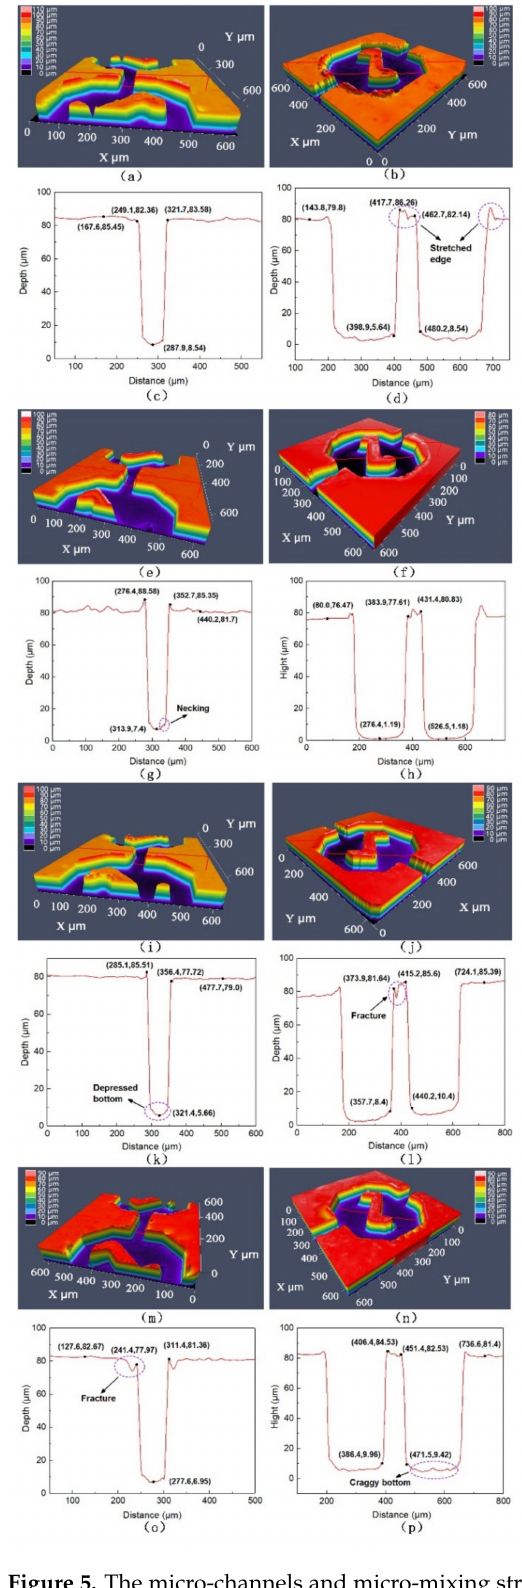
Figure 5. The micro-channels and micro-mixing structures of microfluidic chips of four polymers: ( a , b ) PC, ( e , f ) PMMA, ( i , j ) COC and ( m , n ) PS. The cross section profiles of the micro-channels and micro-mixing structures of microfluidic chips of four polymers: ( c , d ) PC, ( g , h ) PMMA, ( k , l ) COC and ( o , p )